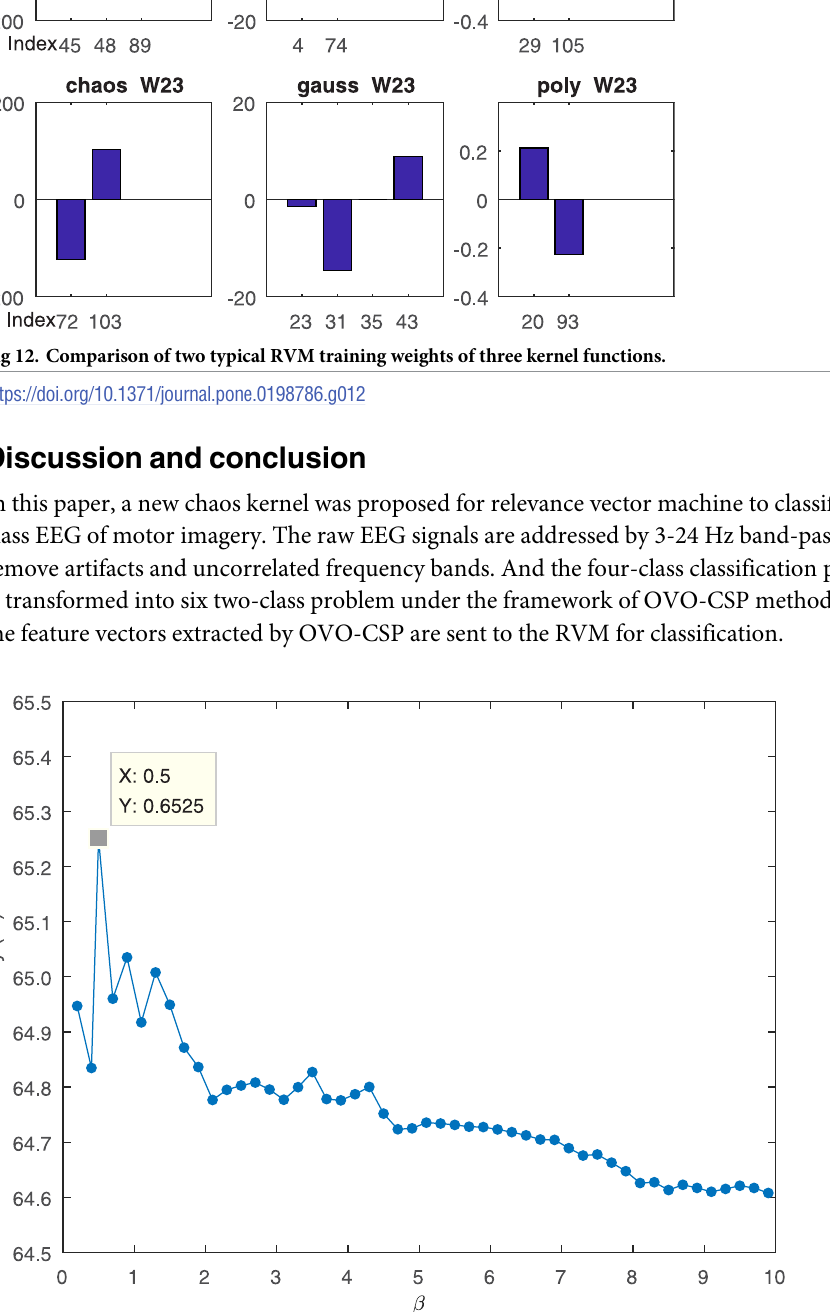
Fig 13. The influence of parameter β on the accuracy of